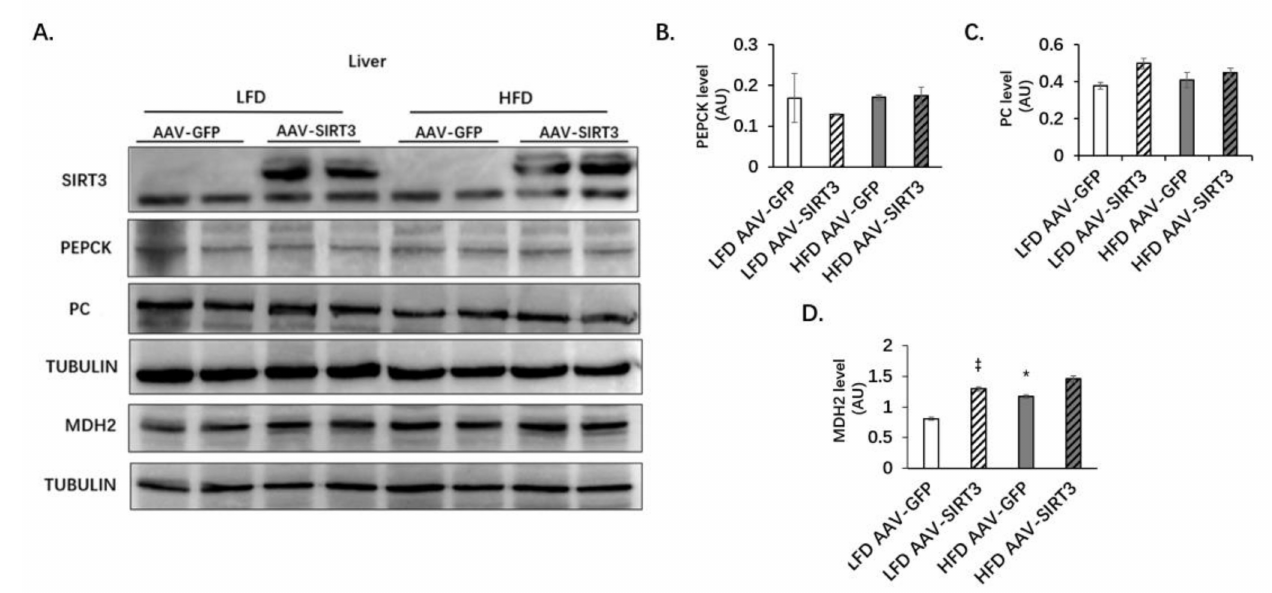
Figure 6. Liver-specific SIRT3 overexpression increases MDH2 protein levels in mice. C57BL/6N male mice of 5–6 weeks of age were injected with AAV-GFP or AAV-SIRT3 via a tail vein and fed with LFD or HFD for 12 weeks. At the 14th week of feeding, mice were euthanized, and the liver tissues were collected. ( A ) Expression of SIRT3 and the levels of gluconeogenic-related enzymes in the liver. ( B ) Quantitative the expression of PEPCK protein level. ( C ) Quantitative the expression of PC protein level. ( D ) Quantification the expression of MDH2 protein level. AU, arbitrary units. The data are mean ± s.e. (error bars). n = 6 mice per group. *, p < 0.05, LFD AAV-GFP vs. HFD AAV-GFP;